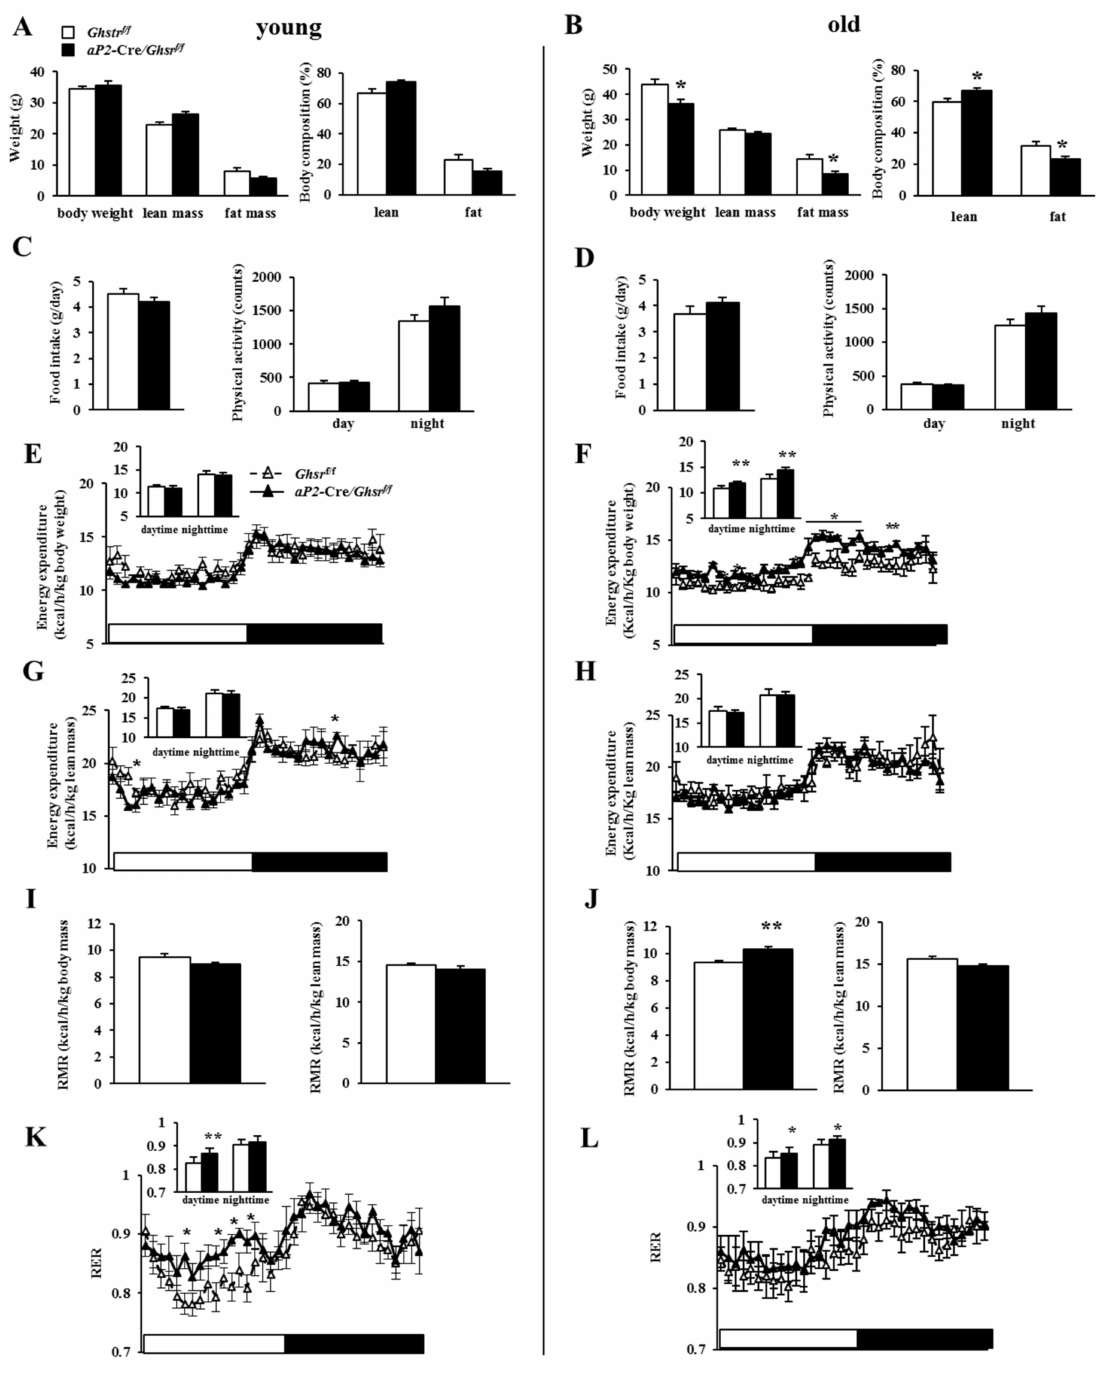
Figure 3. Metabolic profiles of young and old aP2 -Cre/ Ghsr f/f mice. Indirect calorimetry analysis of young (5–6 months) and old (15–17 months) Ghsr f/f and aP2 -Cre/ Ghsr f/f mice. ( A , B ) Body weight and body composition of Ghsr f/f and aP2 -Cre/ Ghsr f/f mice; ( C , D ) daily food intake and physical activity of Ghsr f/f and aP2 -Cre/ Ghsr f/f mice. Energy expenditure (EE) by body weight ( E ) or lean mass ( G ), resting metabolic rate (RMR) ( I ), and respiratory exchange ratio (RER) ( K ) of young Ghsr f/f aP2 -Cre/ Ghsr f/f mice; EE by body weight ( F ) or lean mass ( H ), RMR ( J ) and RER ( L ) of old Ghsr f/f aP2 -Cre/ Ghsr f/f mice. n = 5 in each group. * p < 0.05, ** p < 0.001 Ghsr f/f vs. aP2 -Cre/ Ghsr f/f . The results were represented as mean ± S.E.M. Two-tailed Student’s t -test or repeated measures ANOVA was used for statistical